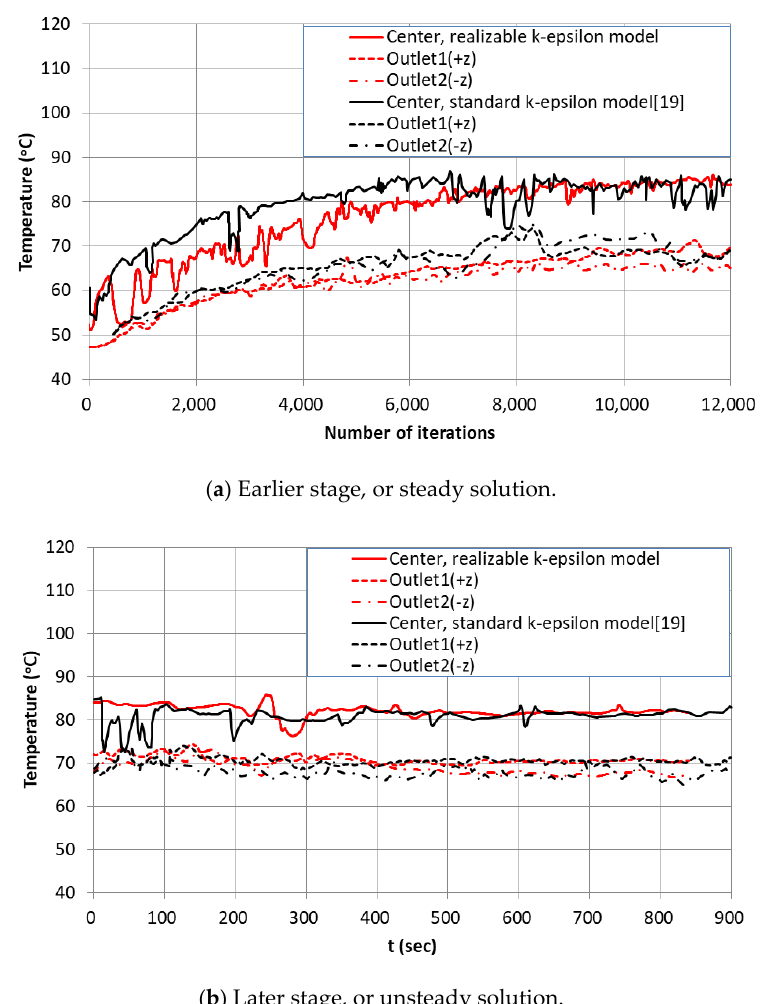
Figure 5. Temperature at the center and two outlets.